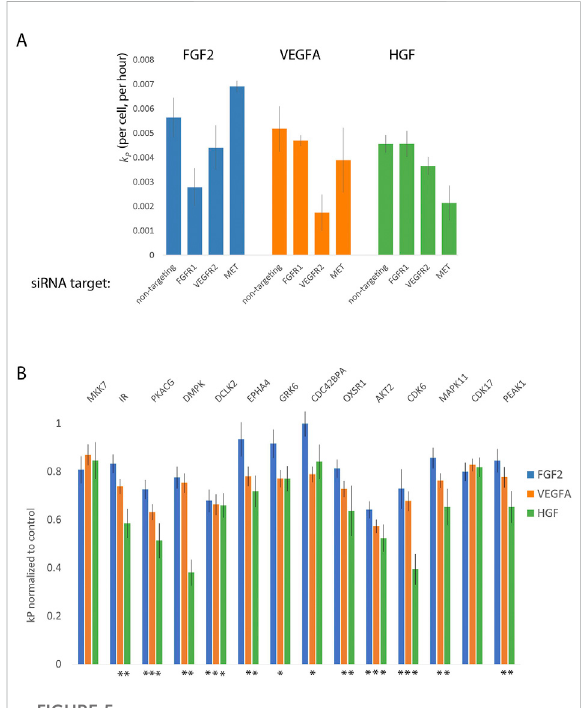
FIGURE 5 Orthogonalevidencesupportingtheroleofkinasesidenti fi ed by Kinome Regression (KIR) Analysis. (A) . Targeting growth factor receptors with 5 nM of siRNA reduces the proliferation rate of Dermal Microvascular Endothelial Cells (DMECs) in the presence of cognate growth factors while minimizing reduction in proliferation in other growth factors. (B) . Targeting kinases with siRNA largely agrees with kinases implicated by KIR. Here, the effect is de fi ned as the average over all three siRNAs used for each kinase and normalized to the no-siRNA control. Error bars are s. e.m. The asterisks indicate growth factors context in which the siRNA targeting a given kinase produced a statistically signi fi cant result ( p < 0 . 05 from multiple comparison